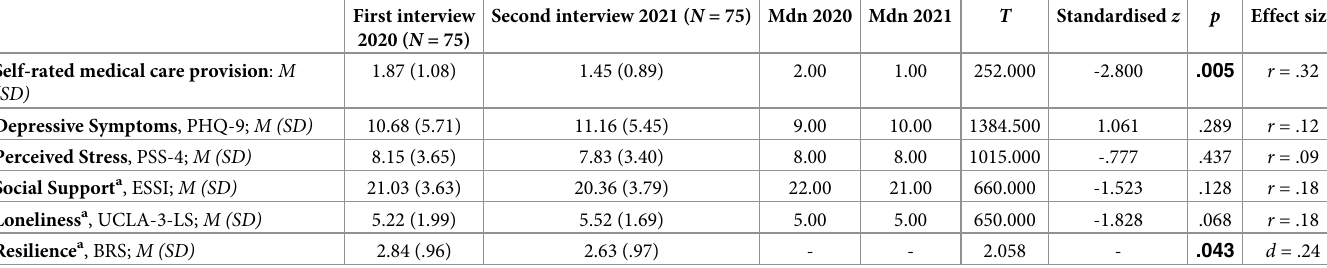
Table 2. Medical care provision, depressive symptoms, and social and emotional aspects (2020 and